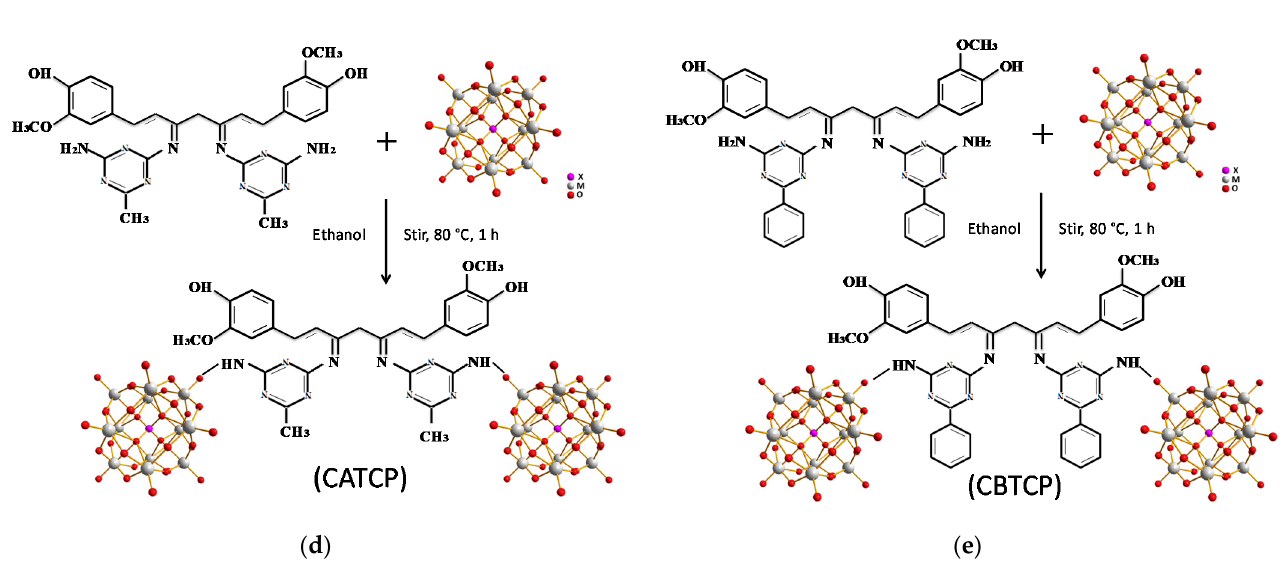
Figure 1. The schematic synthetic procedures and structures of the hybrid materials. ( a ) CP, ( b ) CPA, ( c ) CPB, ( d ) CATCP, and ( e ) CBTCP.